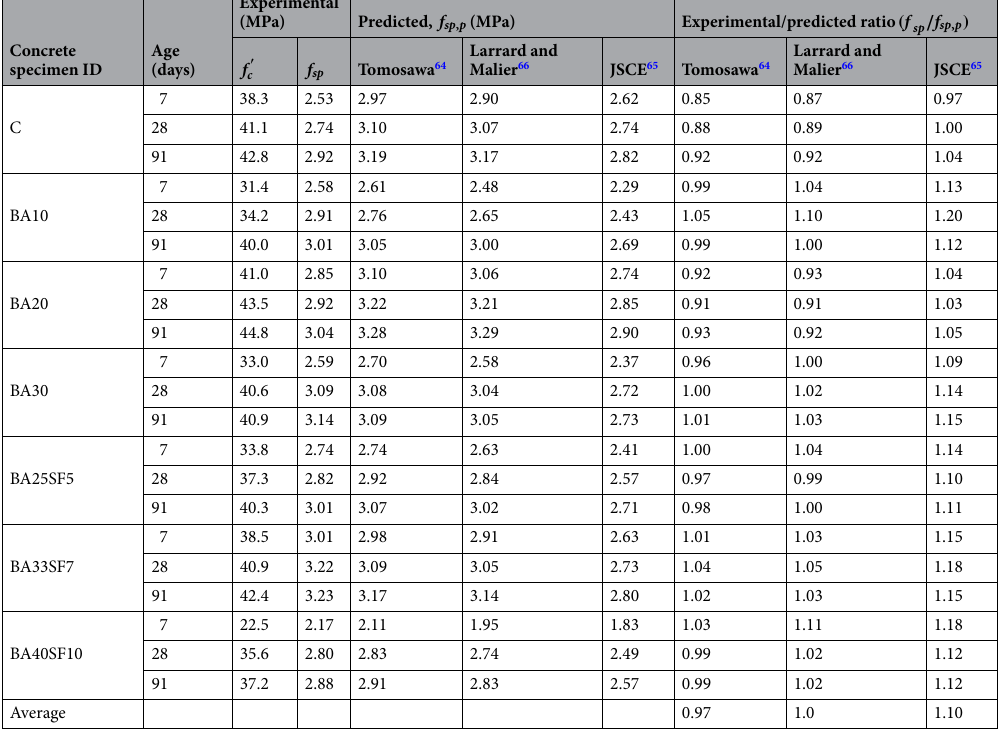
Table 6. Comparison of experimental and predicted tensile strengths of